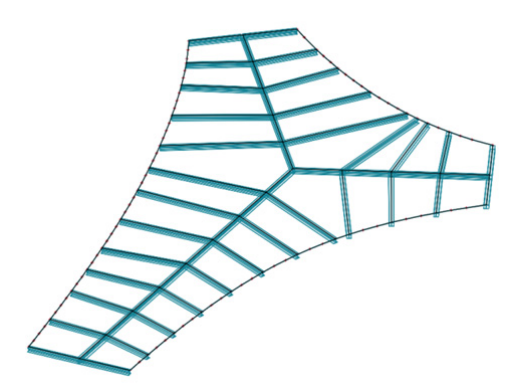
Fig. 11 Roof structure of steel